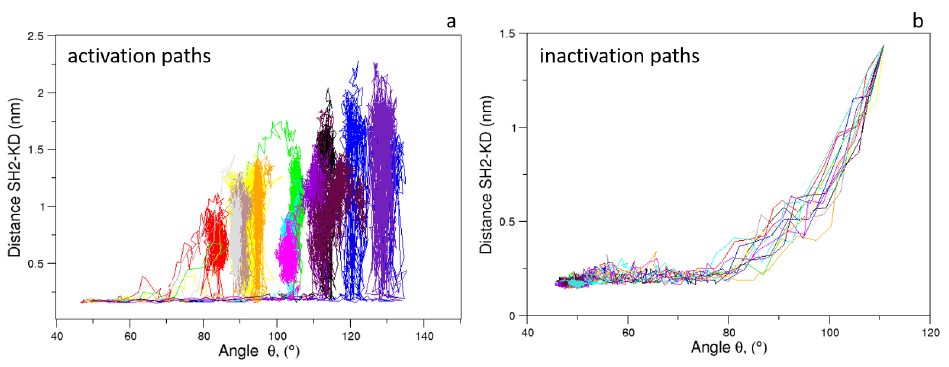
Figure 8. Evolution of the distance d DR vs. angle θ K 23 as observed in the c-Src EDS trajectories for the activation ( a ) and inactivation processes ( b